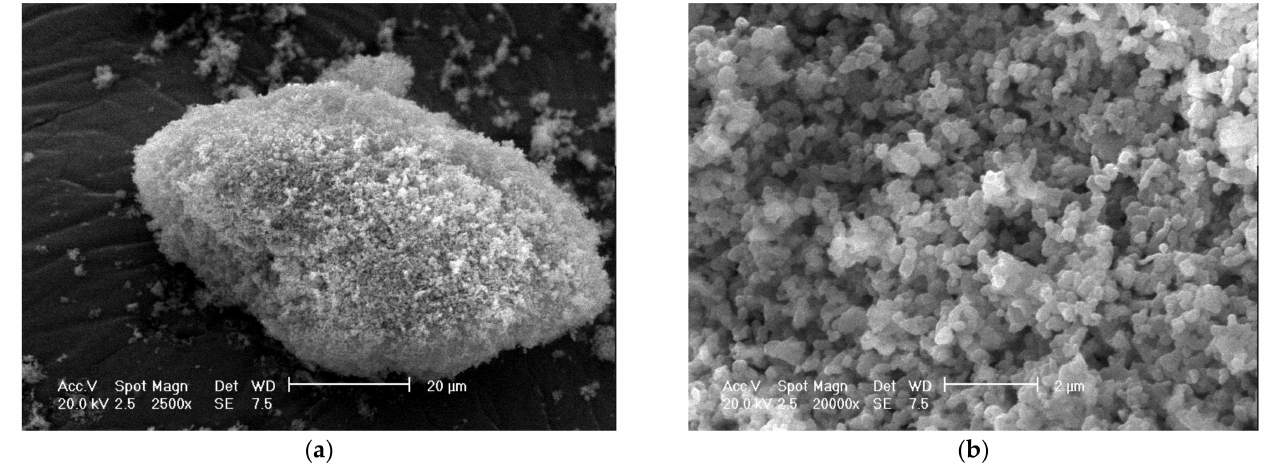
Figure 5. SEM micrographies of C56Ni3 at differents magnifications ( a ) 2500 × ; ( b ) 20,000 ×